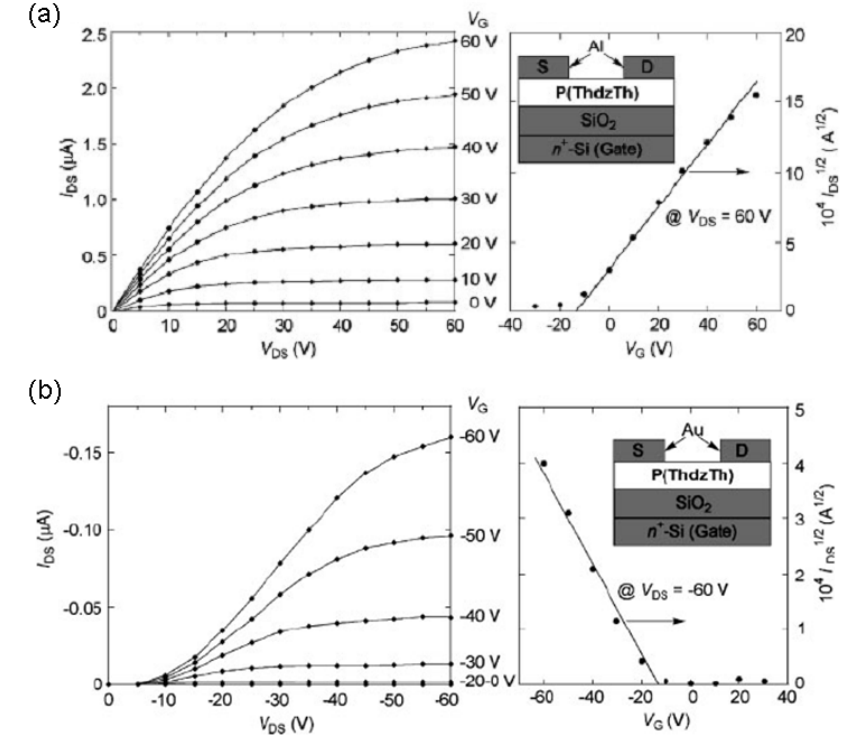
Figure 8. Output and transfer characteristics of P(ThdzTh) -based FETs for n-channel operation (a), and for p-channel operation (b). The insets in (a) and (b) show the structures of the corresponding top-contact FET devices. Reproduced with permission from reference [38]. Copyright 2005 Wiley-VCH Verlag GmbH & Co.